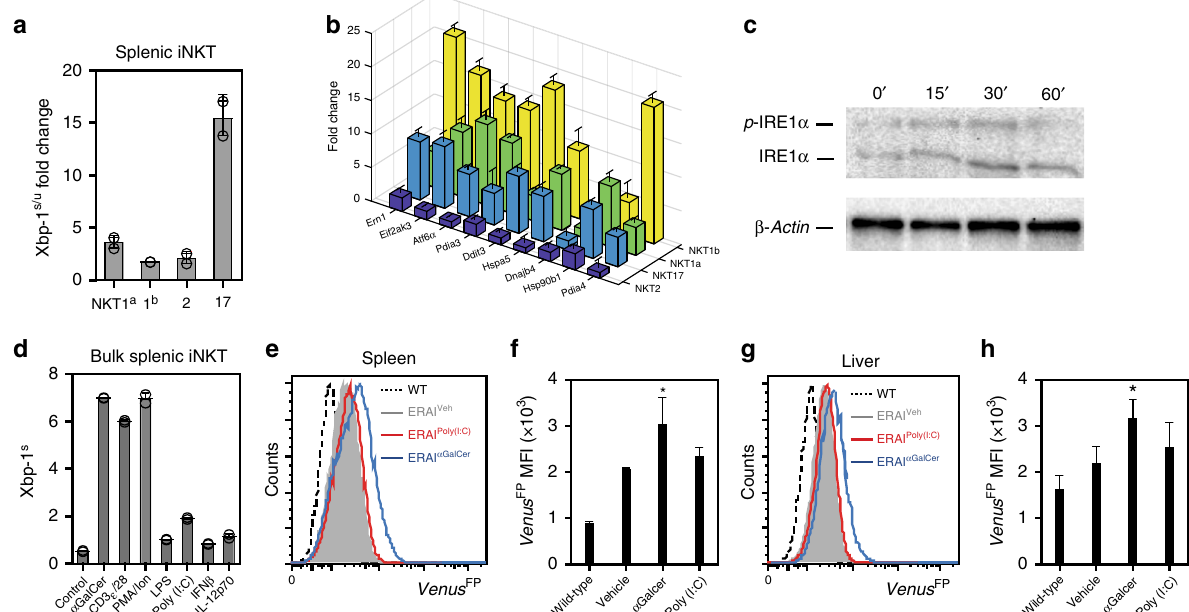
Fig. 2 TCR-dependent stimuli regulate activation of UPR in NKT sublineages. Expanded splenic NKT cell sublineages were restimulated with anti-CD3/ CD28 (3 μ g.ml − 1 /5 μ g.ml − 1 ) for 3 h and fold induction of Xbp-1s/u ( a ) and ER chaperone mRNAs ( b ) in stimulated versus resting cells was assessed by qPCR ( n = 3). Bar chart represents two independent experiments pooled. c Analysis of phosphorylated IRE1 α and total IRE1 α in bulk expanded splenic iNKT cells restimulated with α -CD3 ε /CD28 for the indicated times via phos-tag immunoblot assay. β -Actin represents the loading control. Results represent one of two independent experiments. d qPCR analysis of XBP1s in expanded splenic iNKT cells stimulated with α -GalCer (100 ng/ml),